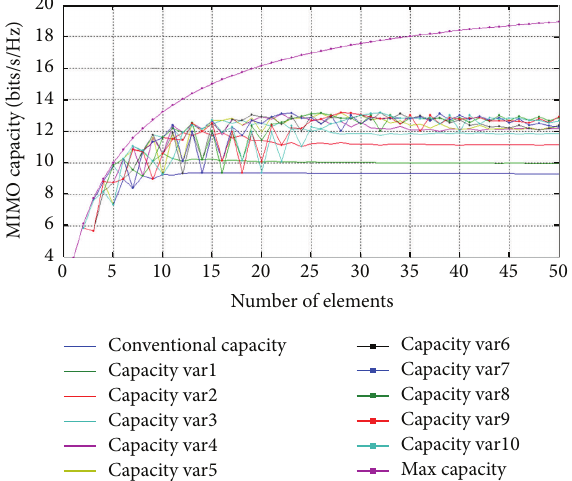
Figure 11: MIMO capacity for the circumference geometry with a SNR = 15dB and a radius of 0.5 𝑑